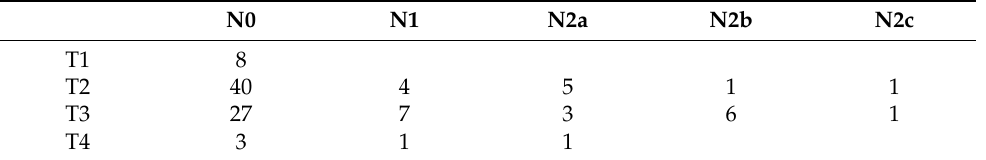
Table 1. Distribution of the N stage in the population with respect to the T